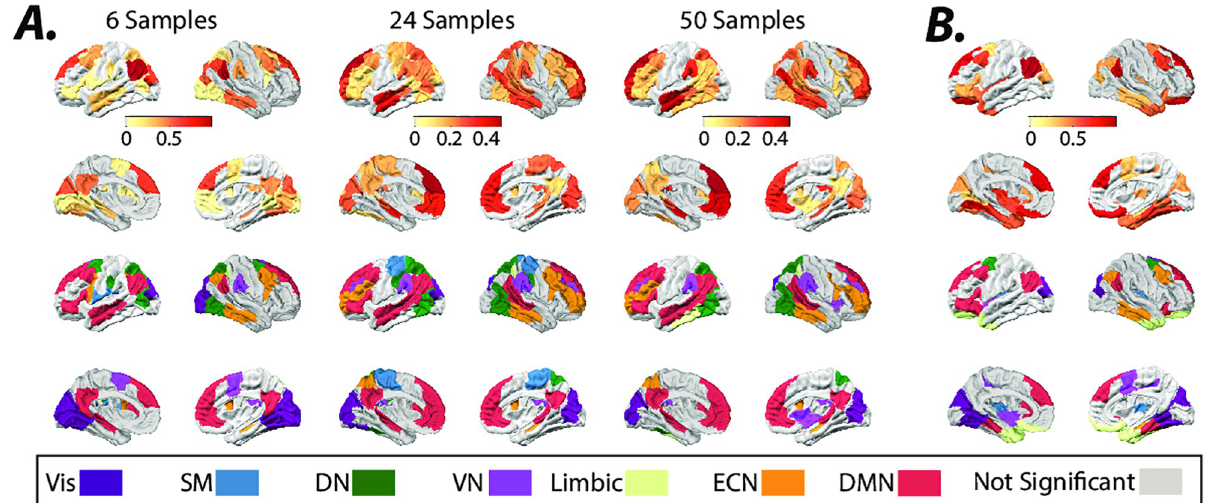
Fig 8. Non-stationarity of estimated external inputs over resting-state scans. (A) Brain overlays on top panels highlight regions with significantly ( t − test, p < 0.05, FDR corrected for multiple comparisons) high normalized (z-scored over all brain regions) fluctuations (i.e., standard deviation) in the normalized (z-score) estimated inputs’ means, measured using sliding windows (6, 24, and 50 samples window length, TR = 0.72 sec). (B) Brain overlays on top panels highlight regions with significantly ( t − test, p < 0.05, FDR corrected for multiple comparisons) high normalized (z-scored over all brain regions) nonlinear non-stationarity index developed by [49], calculated from the normalized (z-score) estimated inputs. The color-coded regions in the bottom plots in panels A and B highlight the allegiance of brain regions in top panels to the seven resting-state networks identified by [50].